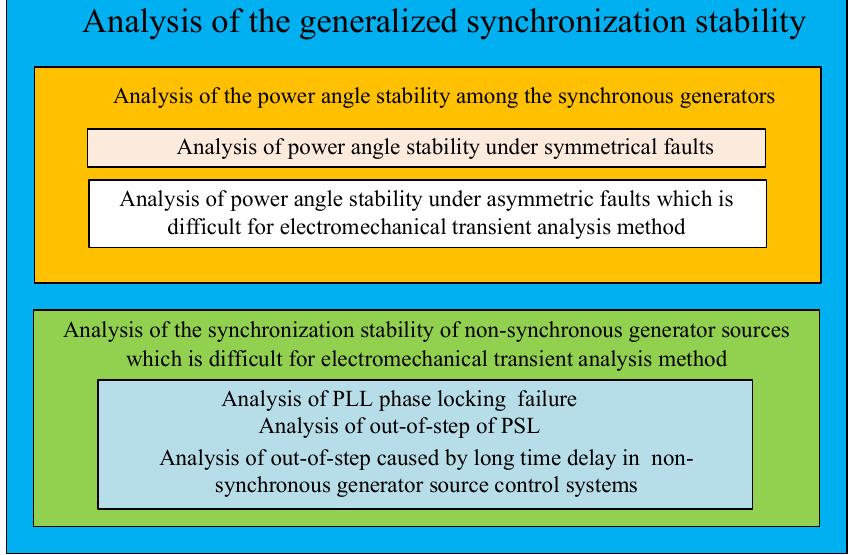
Figure 9. Inclusion relationship between generalized synchronization stability analysis and power angle stability analysis.